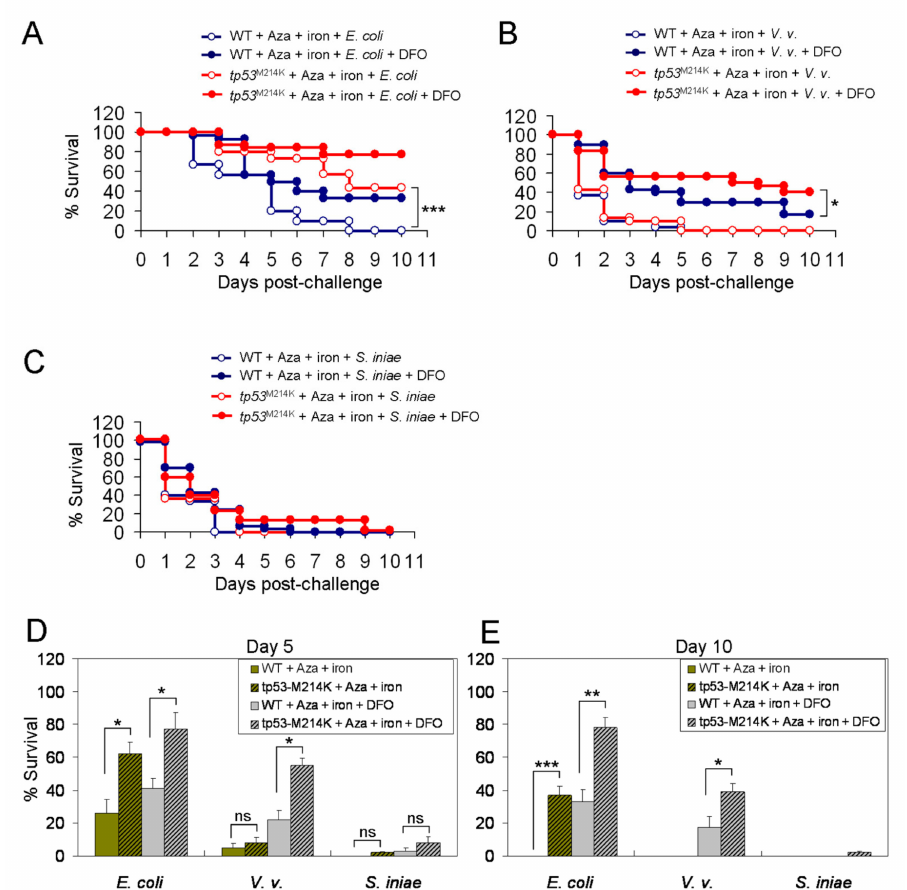
Figure 8. Prolonged survival to bacterial infection in azacitidine-treated zebrafish carrying the tp53 M214K mutation irrespective of iron. The Kaplan–Meier survival curve of mock- or azacitidine-pretreated WT or tp53 M214K mutant zebrafish challenged in the presence of indicated compounds together with ( A ) E. coli (10 7 CFU), ( B ) V. vulnificus (10 5 CFU) or ( C ) S. iniae (10 3 CFU), n = 30 for each group, analyzed by the Kaplan-Meier log rank test. The Day-5 ( D ) and Day-10 ( E ) survival rates are shown. Results are mean ± SD of three independent experiments. * p < 0.05, ** p < 0.01, *** p < 0.001, ns, not significant, by Student’s t